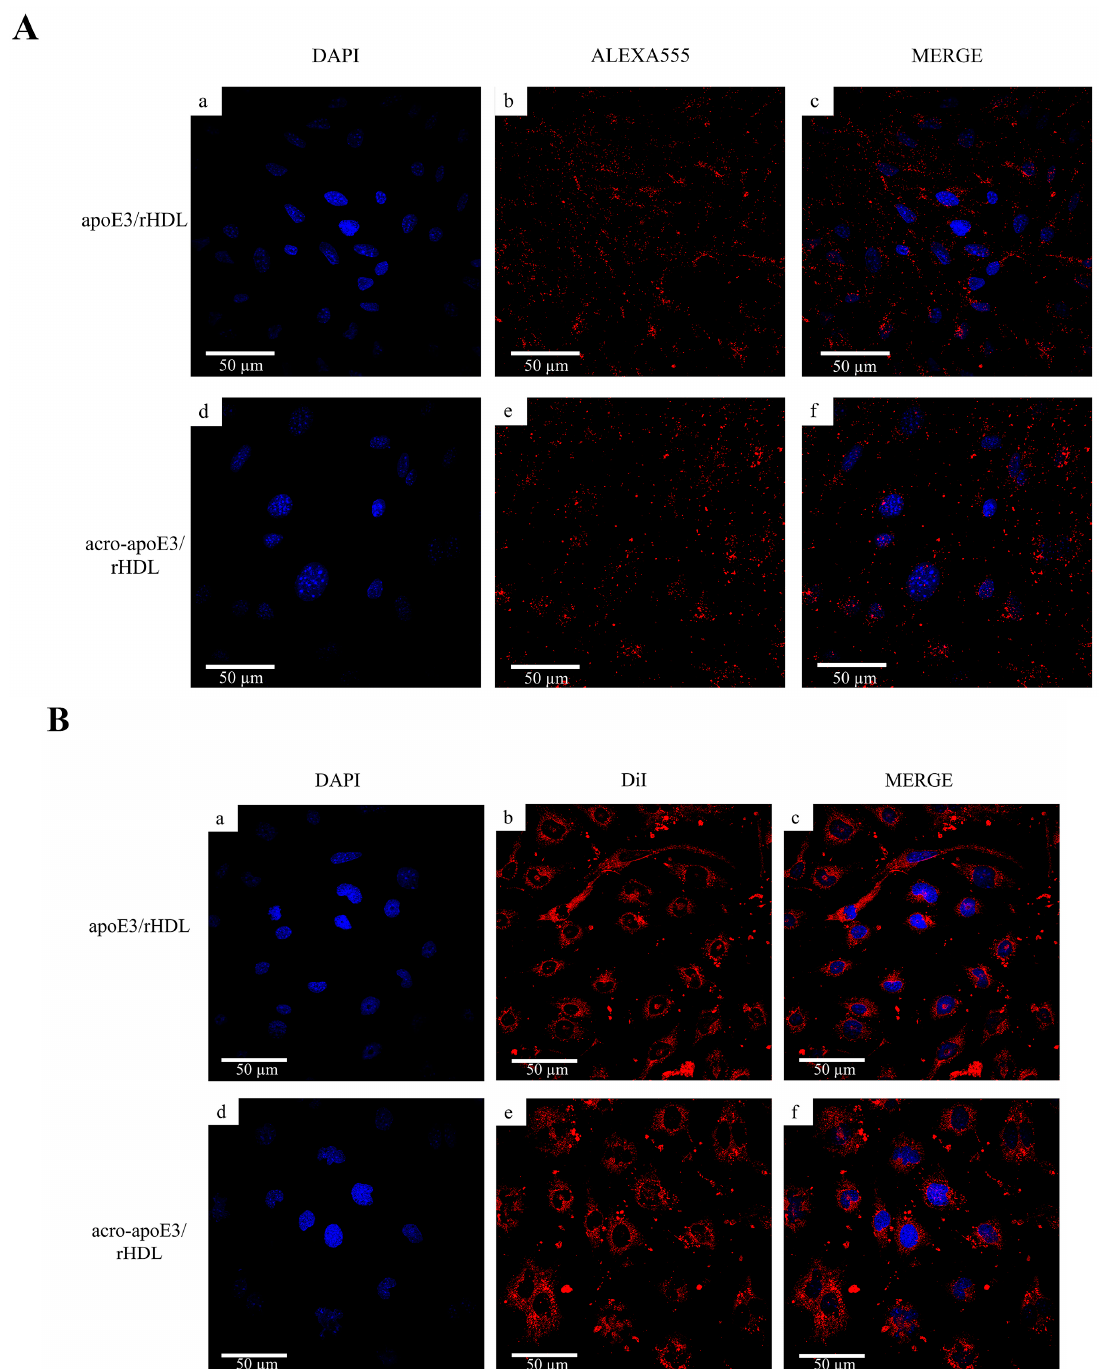
Figure 4. Uptake of apoE3 / rHDL and acro-apoE3 / rHDL by bEnd.3 cells. ( A ) Uptake followed by immunofluorescence. Uptake of rHDL was visualized by immunofluorescence following exposure to 3 µ g / mL apoE3 / rHDL (a–c) or acro-apoE3 / rHDL (d–f) for 2 h at 37 ◦ C. ( B ) Uptake followed by direct fluorescence of DiI. Uptake experiments were carried out as above in the presence of DiI-labeled apoE3 / rHDL (a–c) or acro-apoE3 / rHDL (3 µ g / mL) (d–f). The panels show fluorescence of DAPI (a,d), DiI (b,e), and Merge (c,f).